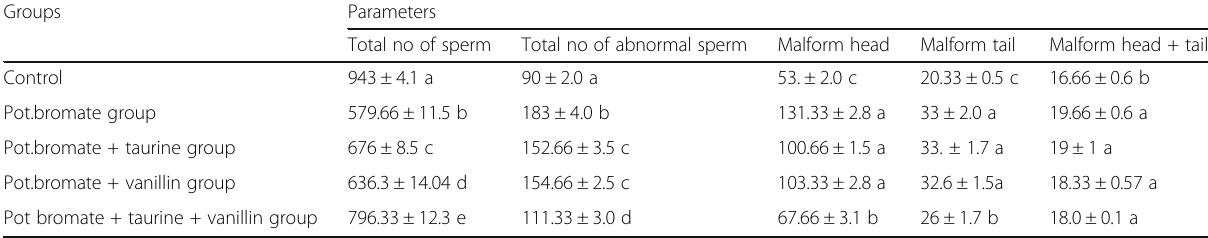
Table 2 Effect of taurine and/or vanillin on spermatic count of the potassium bromate-treated rats Groups